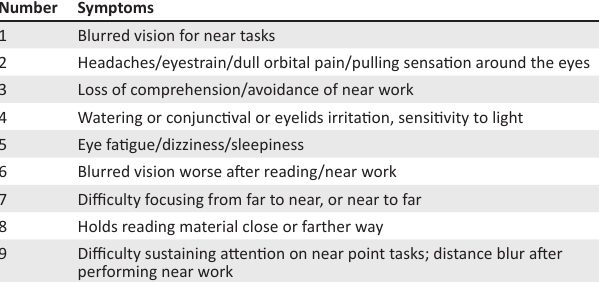
Number Symptoms